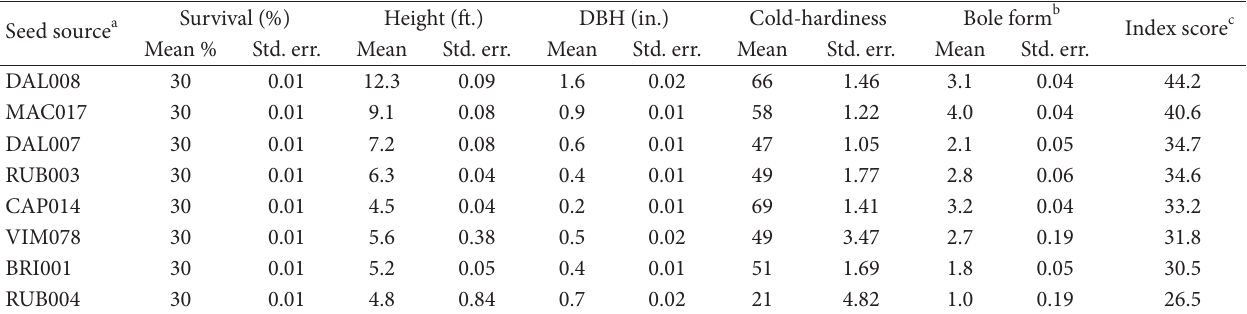
T 2: Sample output from the simulator of the North Carolina State University Hardwood Cooperative eucalypts seed source evaluation program at 24 months from planting.